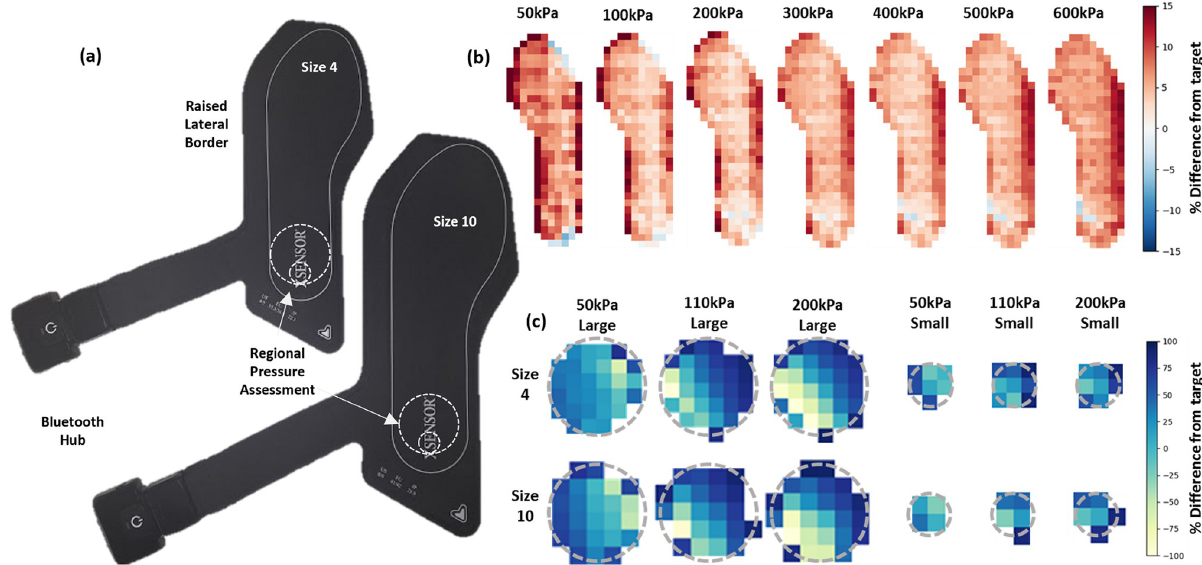
Fig 1. (a) XSENSOR insole showing location of placement of cylinders for regional assessment (dashed lines). (b) Average peak pressure maps for difference from target pressures for whole insole protocol. (c) Regional protocol, with cylinder area overlay (dashed lines) sensor size has been scaled to correct for differences between XSENSOR insole